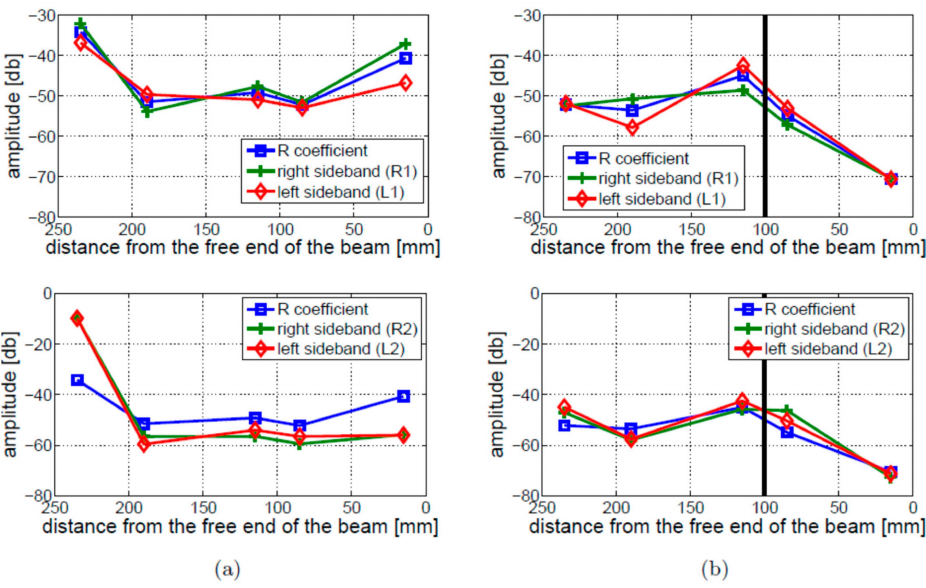
Figure 18. Experimental Test 1—a parametric study of nonlinear vibro-acoustic modulations analyzed using the first (top figures) and second (bottom figures) pairs of sidebands: ( a ) intact beam; ( b ) cracked beam. The crack position is indicated by the vertical black solid line. The horizontal axis corresponds to the measurement